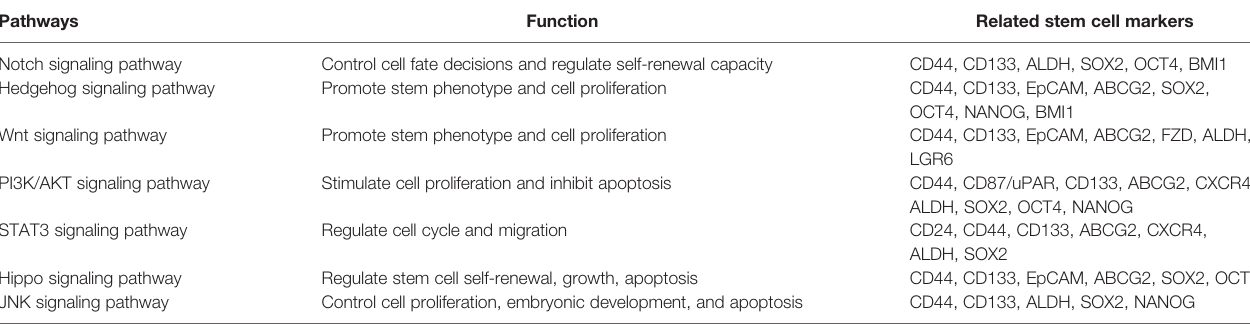
TABLE 3 | Signals sustaining lung cancer stem cells and related stem cell